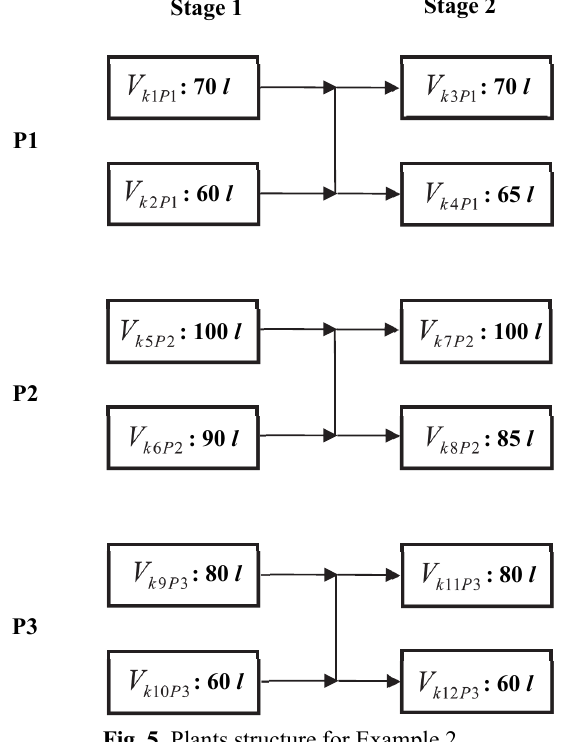
Fig. 5. Plants structure for Example 2